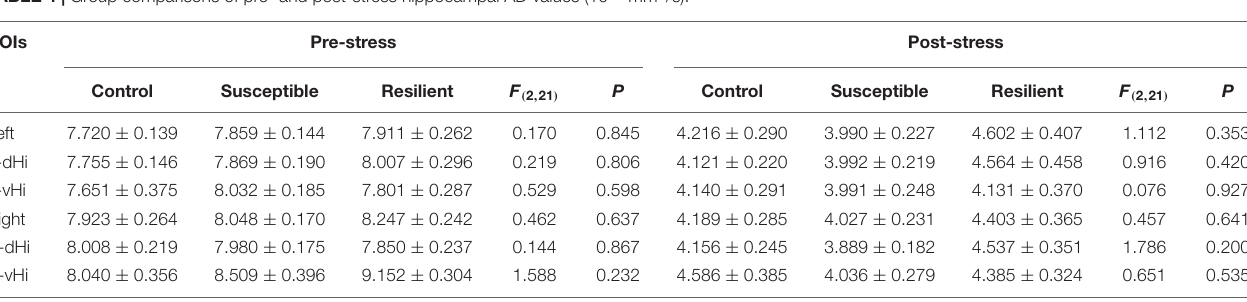
TABLE 4 | Group comparisons of pre- and post-stress hippocampal AD values (10 − 4 mm 2 /s). ROIs Pre-stress Post-stress Control Susceptible Resilient F ( 2 , 21 ) P Control Susceptible Resilient F ( 2 , 21 )